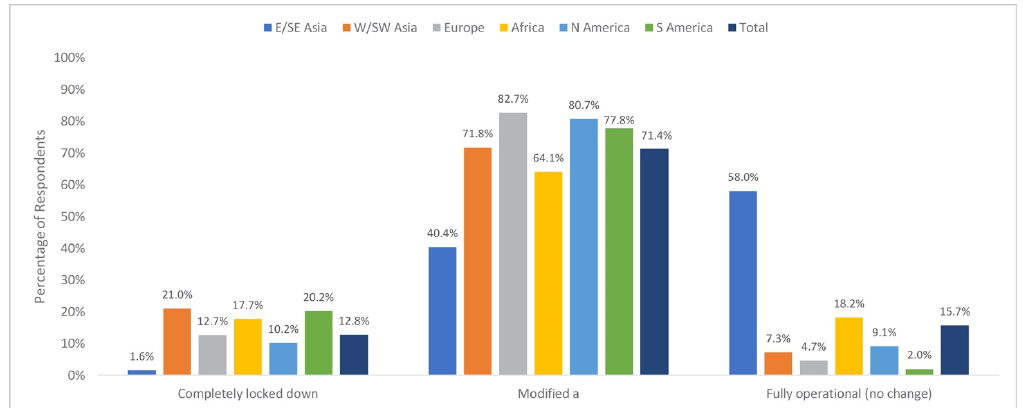
Figure 1 . Changes in consultations in the Outpati ent Clinic by Region—Completely . Locked vs. Modified